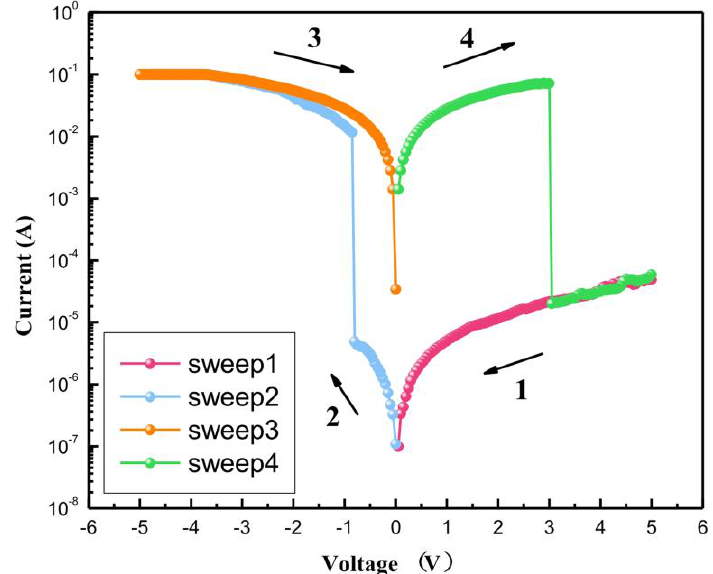
Figure 3. Current-voltage (I-V) characteristics of Al/ Bombyx mori body fluid film/ITO biomemristor.